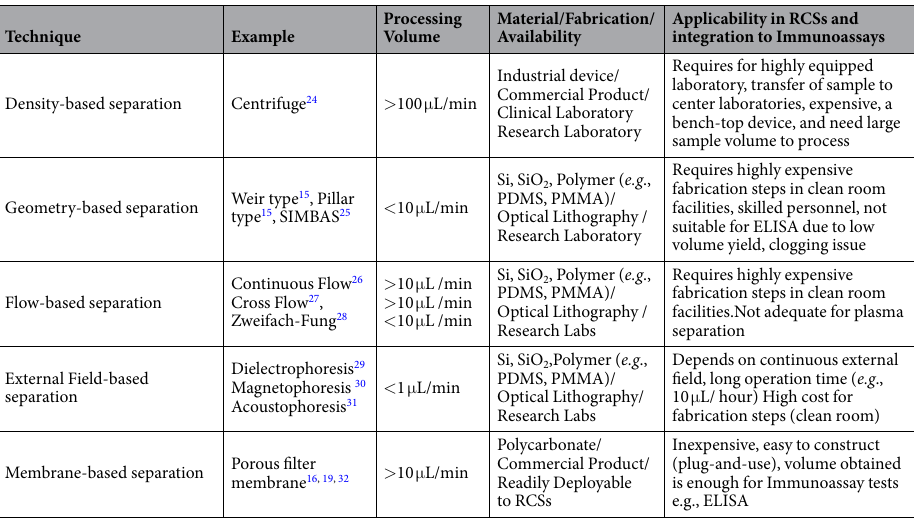
Table 2. Comparison of filtration techniques for the separation of plasma from whole